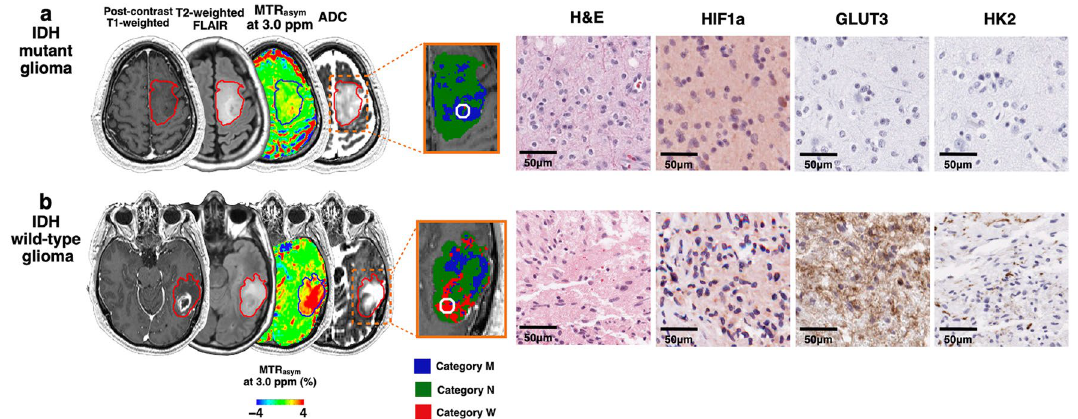
Figure 5. MR images and corresponding hematoxylin and eosin (H&E) and immunohistochemistry staining for MRI-guided biopsy targets (circles). ( a ) IDH mutant glioma for which an area with labels categorized as M , indicating the IDH mutant feature, was biopsied. Expressions of HIF1a, GLUT3, and HK2 are low in the slides from a 5-mm radius sample taken from the MRI-guided biopsy target. ( b ) IDH wild-type glioma for which an area with labels categorized as W , indicating IDH wild-type feature, was biopsied. Expressions of HIF1a, GLUT3, and HK2 are